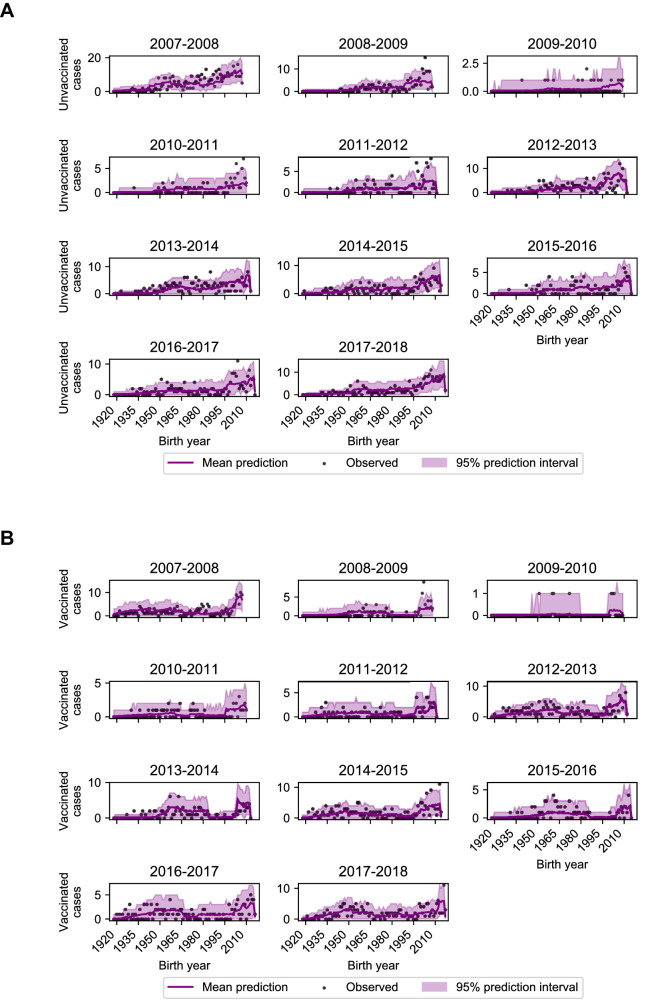
Model performance on excluded seasons.Each panel shows the number of observed and predicted cases by birth year among unvaccinated (A) and vaccinated (B) study participants. Predictions and 95% prediction intervals were generated by fitting the model including age-specific risk of medically attended influenza A infection, HA subtype imprinting, and age-specific VE fitted to all seasons except the season in the panel (Appendix 1: ‘Evaluation of predictive power’).